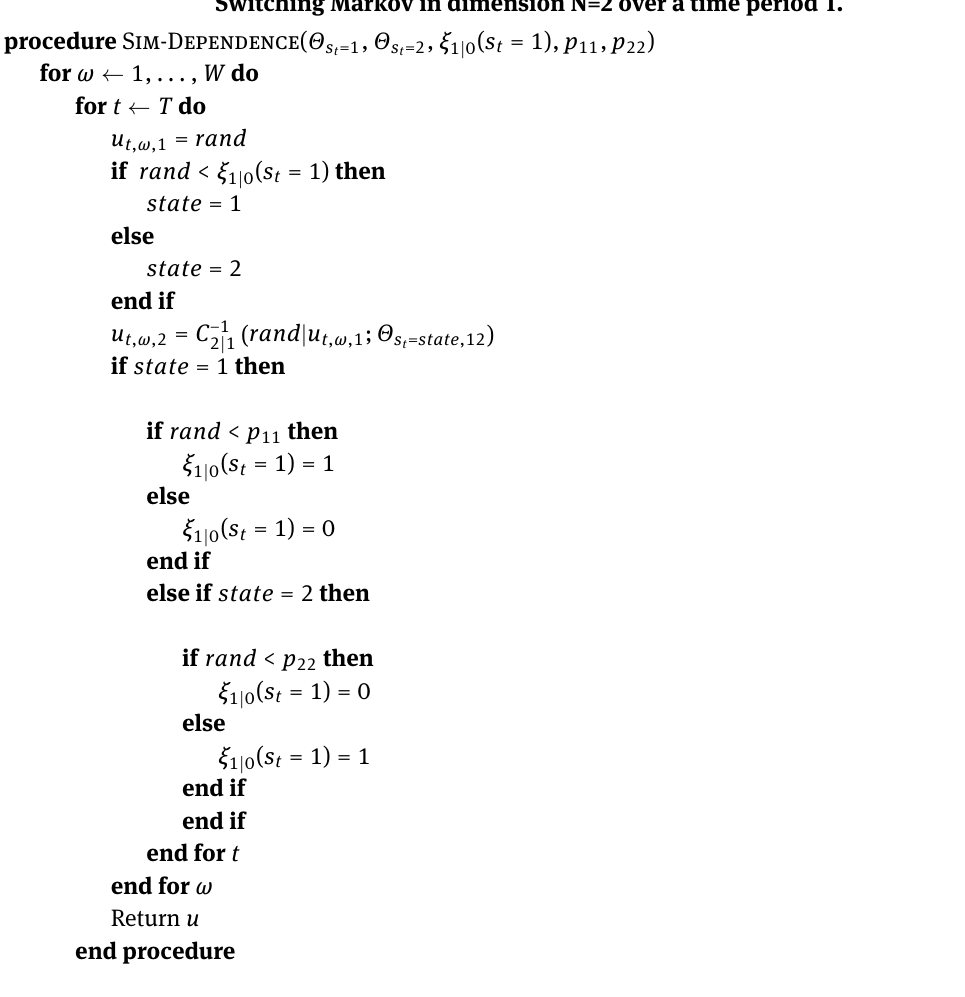
Algorithm 1: Simulation of the dependence under a copula and a dynamic following a two-state Switching Markov in dimension N=2 over a time period